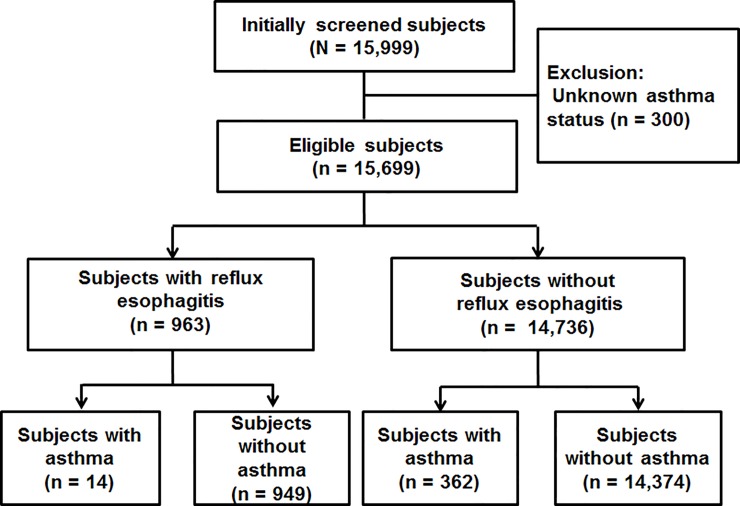
Schematic flowchart for subjects enrolled in this study.A total of 15,699 individuals who underwent health checkups including upper gastrointestinal endoscopy were enrolled in this study.